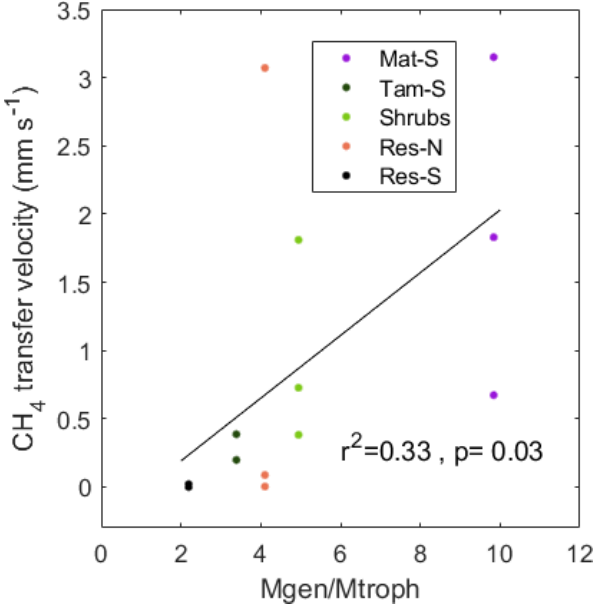
Figure 9. Relationship between the ratio of the relative abundance of methanogenic–methanotrophic lineages (Mgen/Mtroph) and the CH 4 transfer velocity in the top stratigraphic layer of the peat pro- file: 0–6.7cm for Mat and 0–12.5cm for the other zones. CH 4 trans- fer velocity was calculated as the average for the 3 months prior to coring, during which the water level was within or above the top stratigraphic